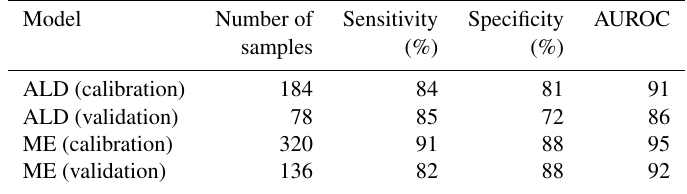
Table 1. Model performance metrics for training (70% samples) and testing (30% samples). Sensitivity and specificity refer to the ability of the respective model to accurately identify the presence and absence of disturbance. AUROC is a measure of overall model fit without the addition of a user-specified